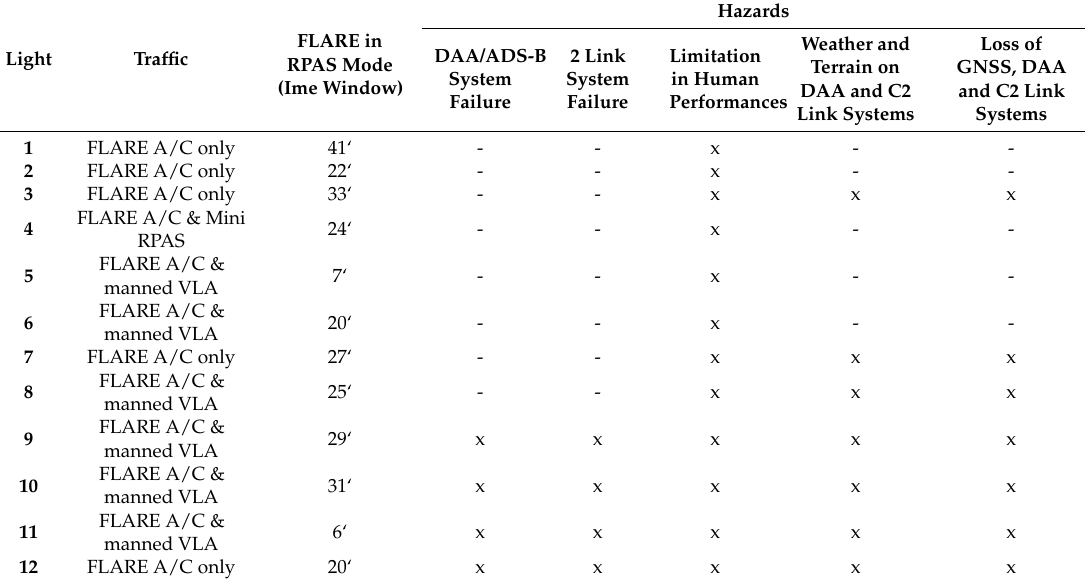
Table 1. RAID flight sorties: Hazards (data from [18]); it contains public sector information licensed under the Open Government Licence v3.0, see